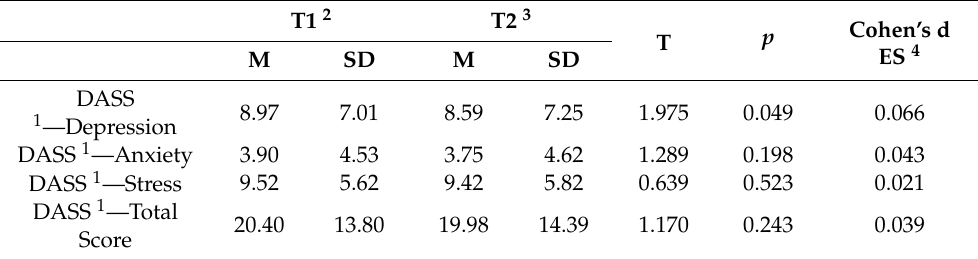
Table 2. Descriptive statistics and changes in psychological distress between T1 and